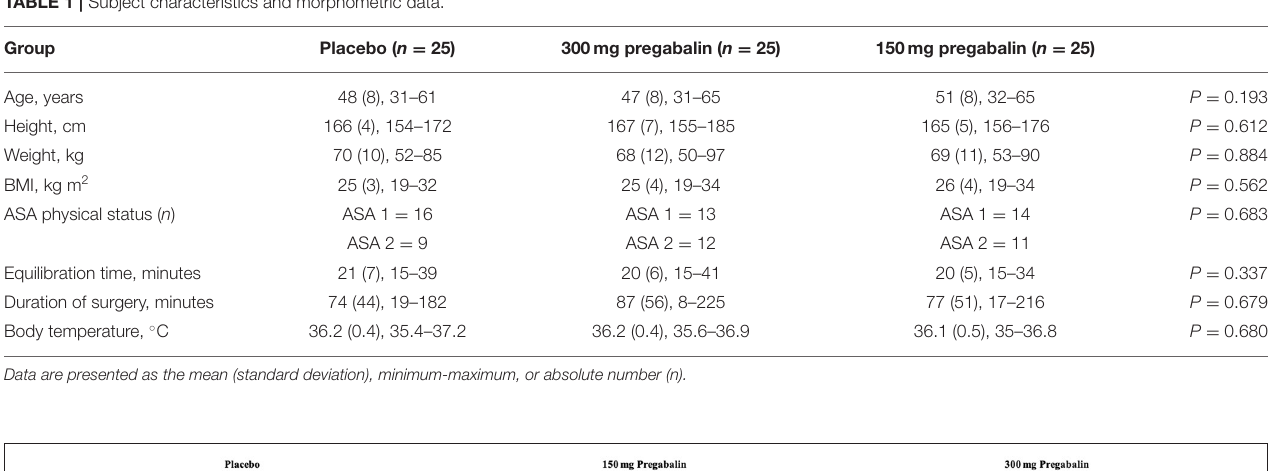
TABLE 1 | Subject characteristics and morphometric data.